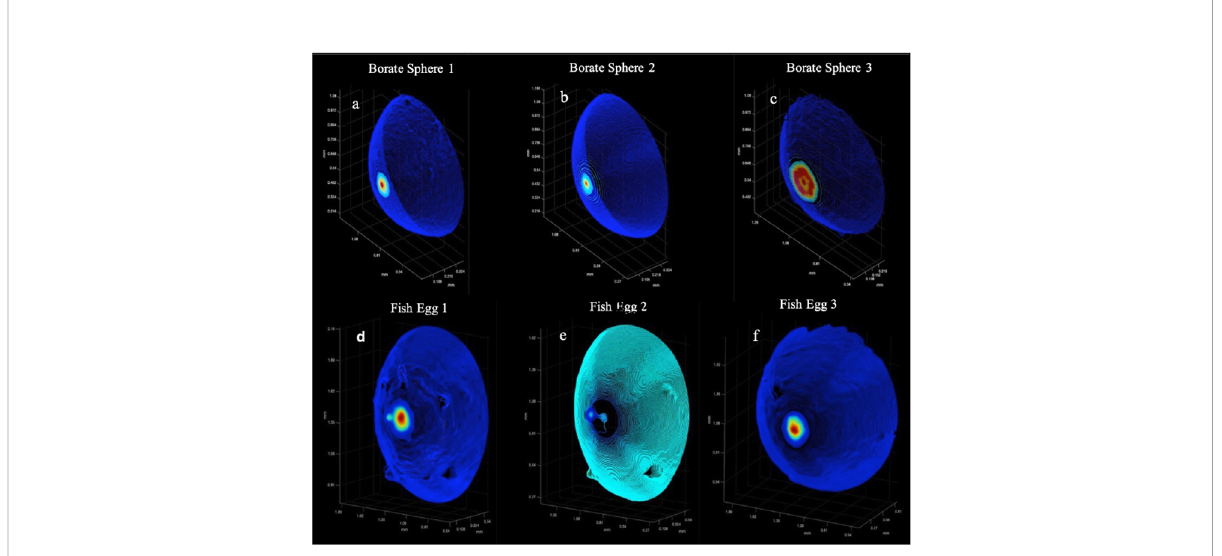
FIGURE 8 The calibration targets: A montage of the 3D point clouds. (A – C) are the Borate spheres. (D – F) are the Flying Fish Eggs. Color denotes backscatter strength with red as high and dark purple as